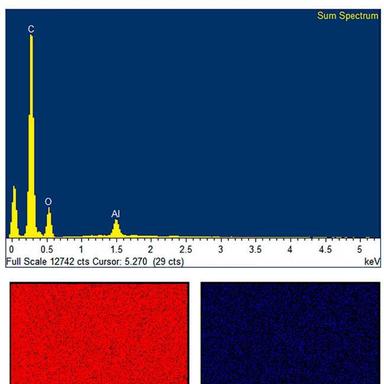
X-ray spectrum and the elemental mapping images of sample 16.